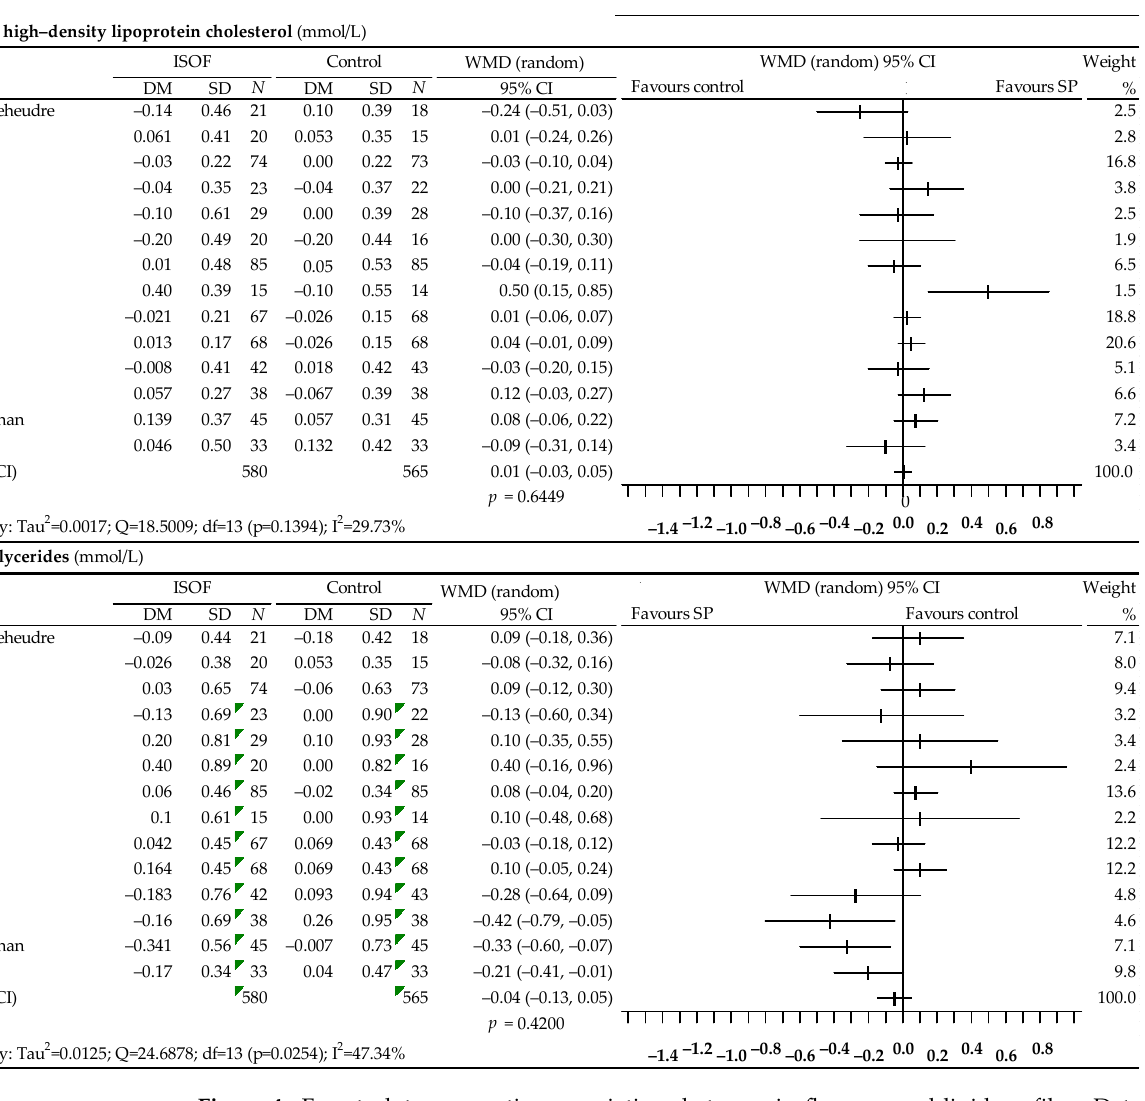
Figure 4. Forest plot representing associations between isoflavones and lipid profiles. Data are presented as the weighted mean difference with 95% CI.